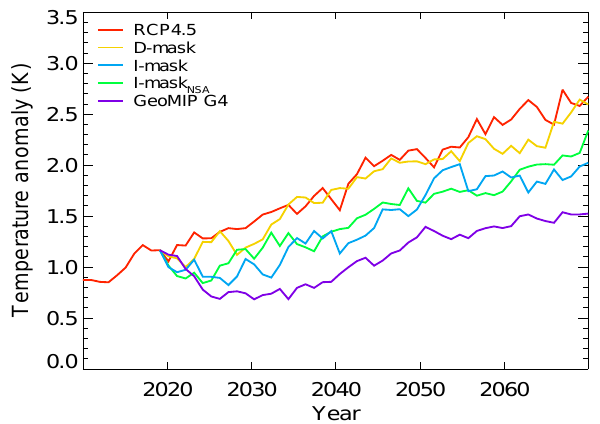
Fig. 5. Evolution of global-mean near-surface temperature anomaly (K) with respect to the pre-industrial